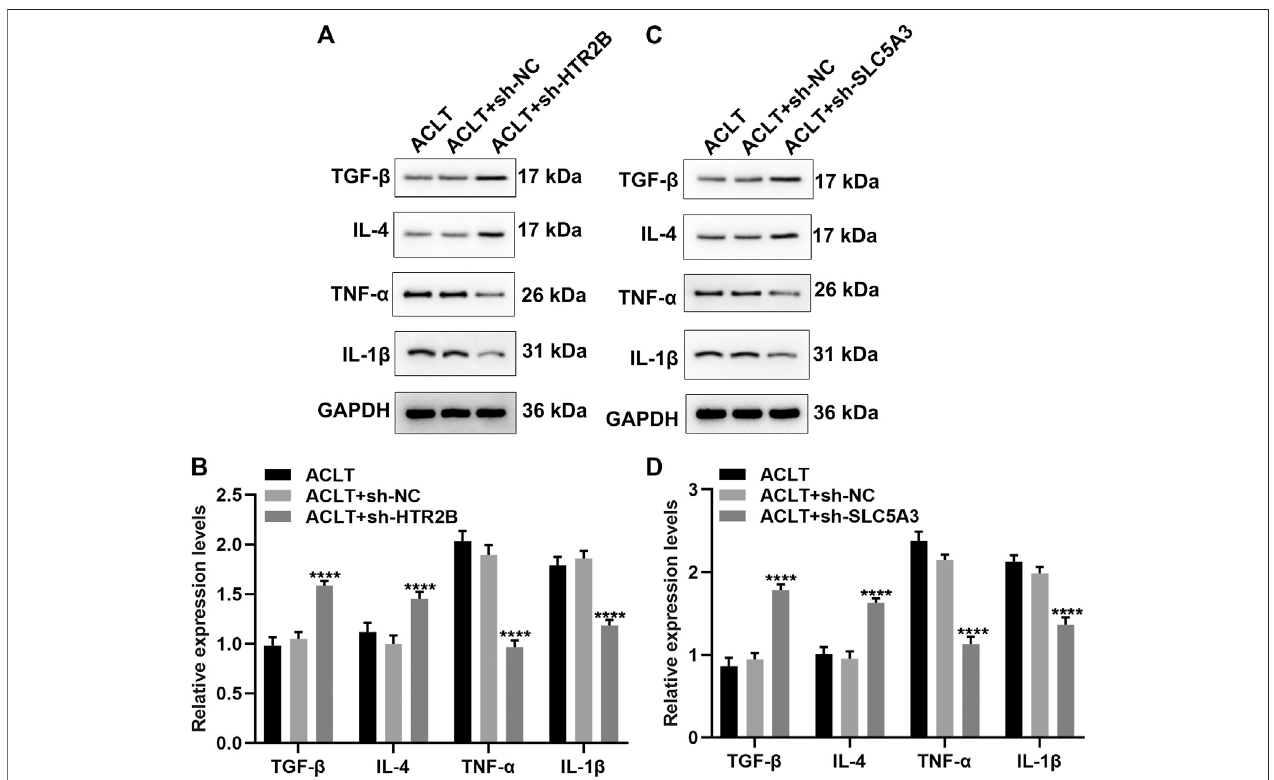
FIGURE 9 | The roles of silencing HTR2B or SLC5A3 on in fl ammatory response of OA synovial cells. (A – D) Western blot for examining the expression of TNF- α , IL-1 β , TGF- β and IL-4 in OA synovial cells transfected with (A,B) sh-HTR2B or (C,D) sh-SLC5A3. **** p < 0.0001.